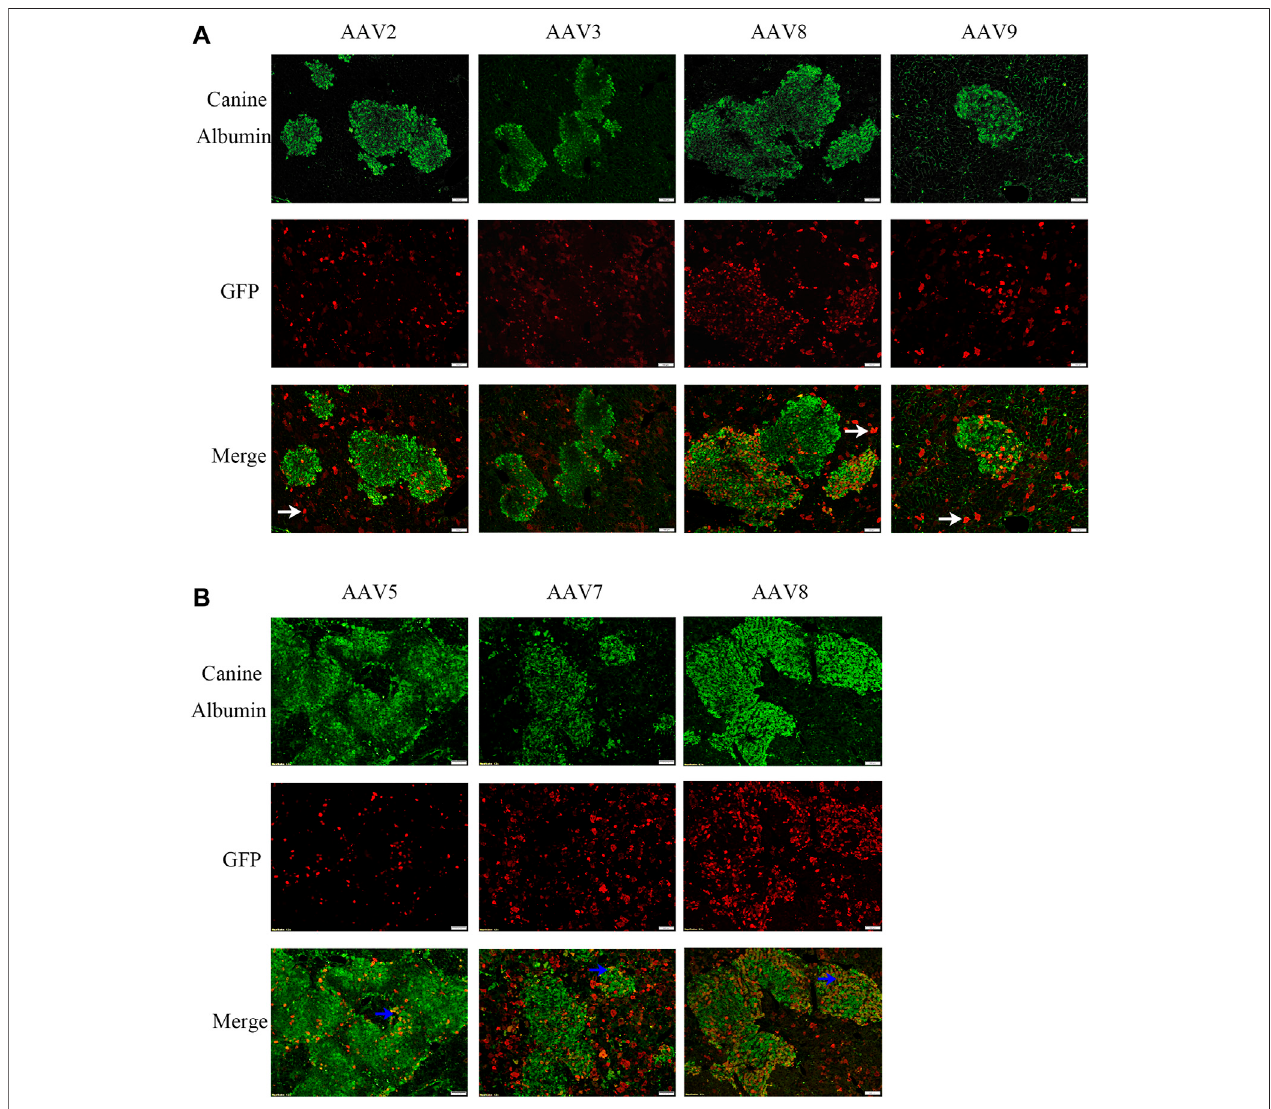
FIGURE1| AAV transduction ef fi ciency ofcaninehepatocytes incanine xenograft mice. AAV vectors ofvarying serotypes packaged withthe GFPtransgenewere administeredincaninehepatocytexenograftmiceatadoseof1×10 11 vg/mouse.Fourweekslater,theliverswereharvested.GFP(red)expressionincaninehepatocytes (green) was detected by immuno fl uorescence. The scale represented 100 μ m. (A) AAV2, AAV3, AAV8 or AAV9 vectors were injected into canine hepatocyte xenograft mice. Hepatocytes were from the same source. (B) AAV5, AAV7 or AAV8 vectors were injected into canine hepatocyte xenograft mice. Hepatocytes were again from the same source. The representative murine hepatocytes which were transduced were indicated by white arrows, while transduced canine hepatocytes were indicated by blue arrows.